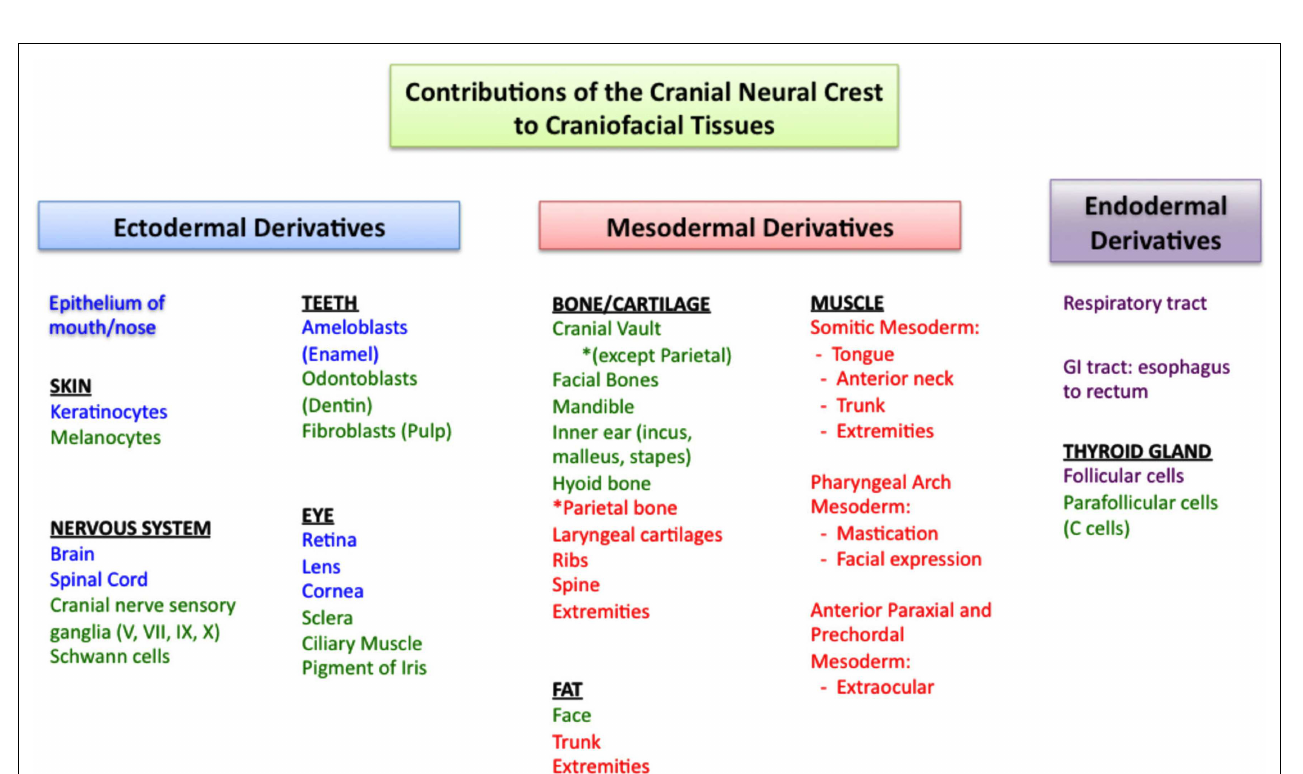
cartilage, and fat, while this is not the case in the trunk and extremities.While all of the craniofacial muscles arise from the mesoderm (red), note that different muscle groups develop from different regions of the mesoderm. References to the developmental origins of the structures in this figure are located throughout the